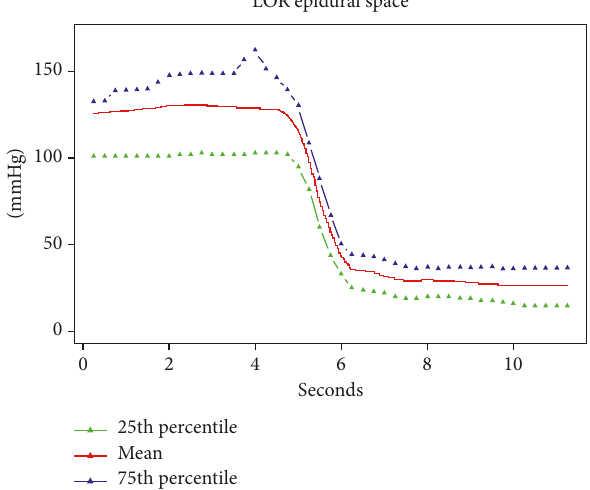
Figure 2: Mean curve (25th and 95th percentile) of the pressure registered by CompuFlo ® when the epidural needle was deemed to be in the ligamenta flava and thereafter in the epidural